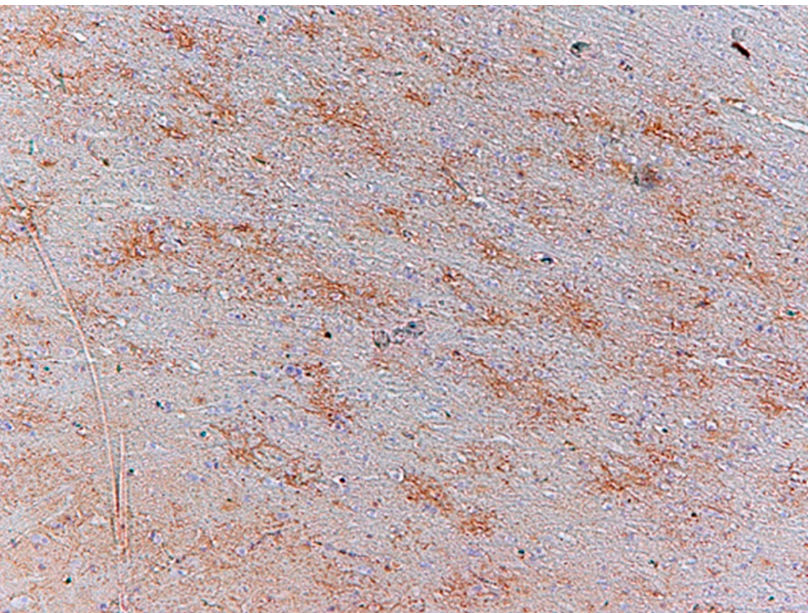
Figure 7. Case no. 8 White matter of the occipital lobe. Positive immunohistochemical reaction with GLT ‐ 1. We did not observe any neuropathological changes in glutamate transporter in astrocyte processes. Magnification 200×.